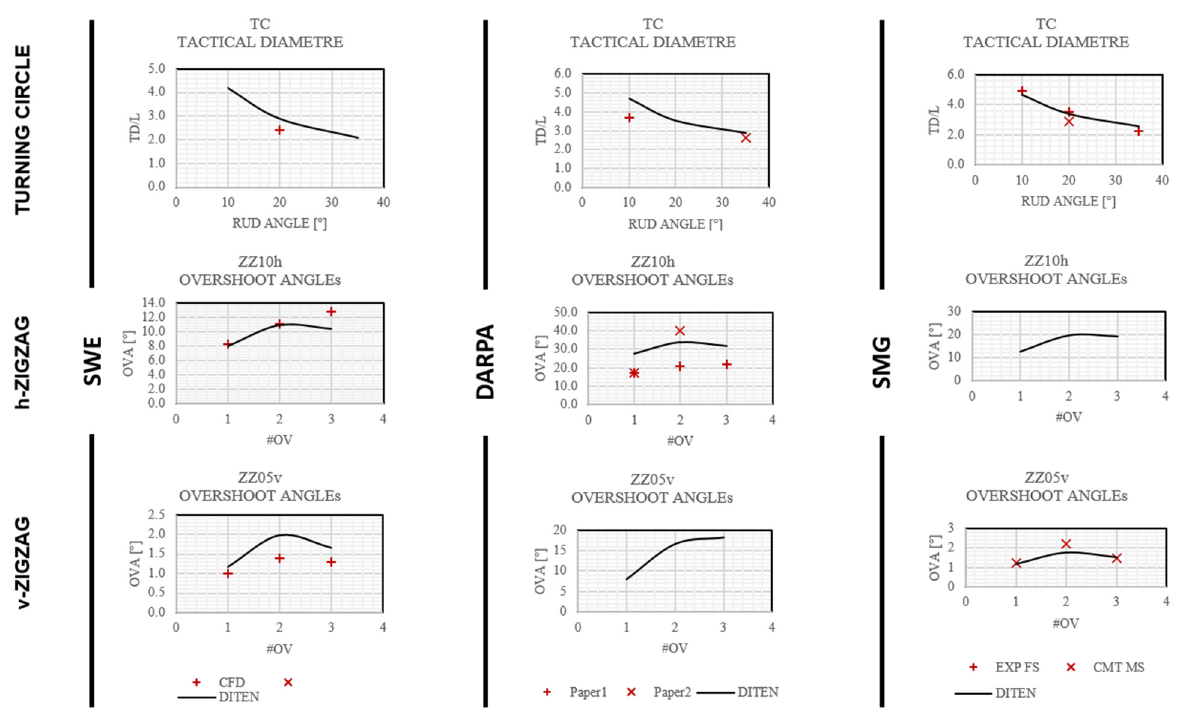
Figure 12. Manoeuvring validation.